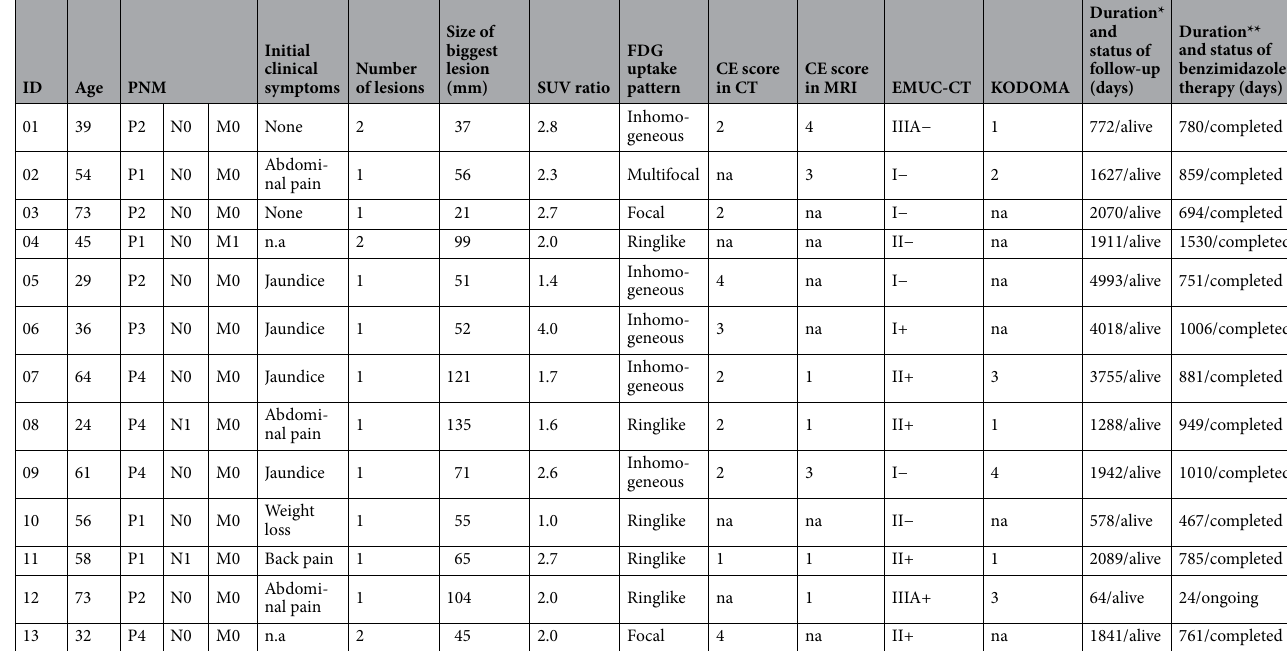
Table 2. Patient demographics of all patients with curative operations of alveolar echinococcosis. ID patient identification, PNM (PNM stage: P = parasitic mass in the liver, N = involvement of neighboring organs, M = metastasis), SUV standardized uptake value, FDG 18 F-fluorodeoxyglucose, CE score contrast enhancement score (1: no enhancement, 2: most likely no enhancement, 3: suspicion for enhancement, 4: enhancement), CT computed tomography, MRI magnetic resonance imaging, EMUC-CT EMUC-CT classification 17 ,